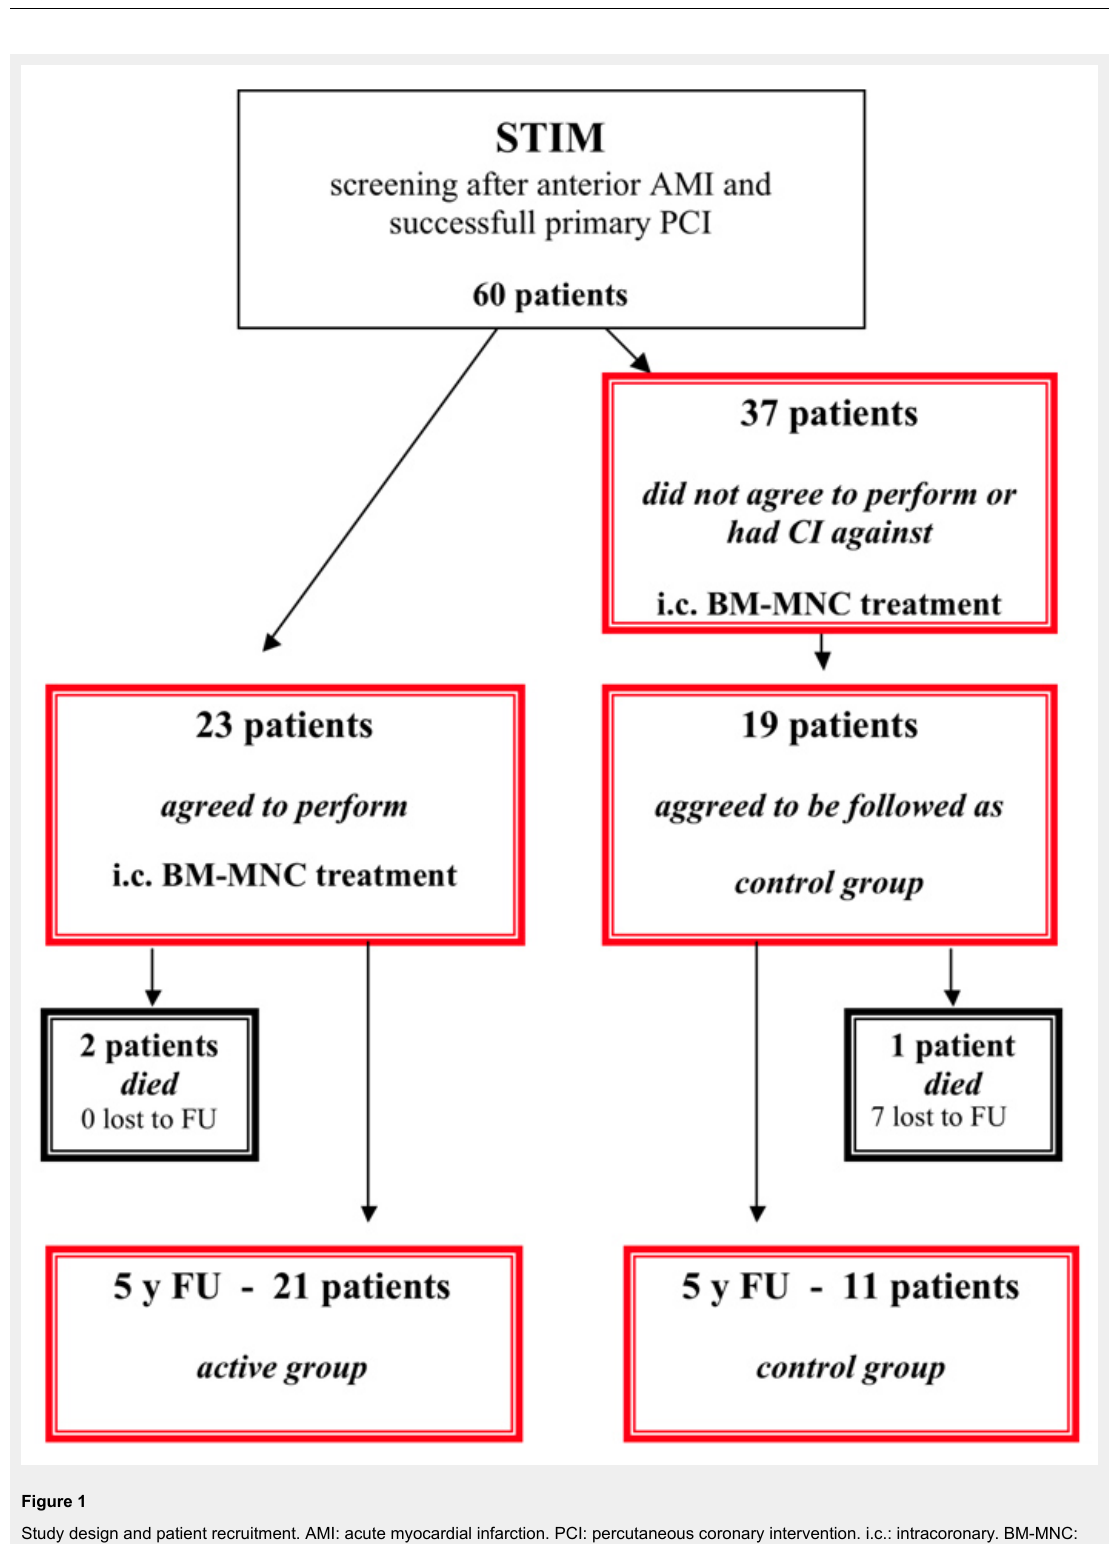
Figure 1 Study design and patient recruitment. AMI: acute myocardial infarction. PCI: percutaneous coronary intervention. i.c.: intracoronary. BM-MNC: autologous bone marrow derived mononucleated cells. FU: